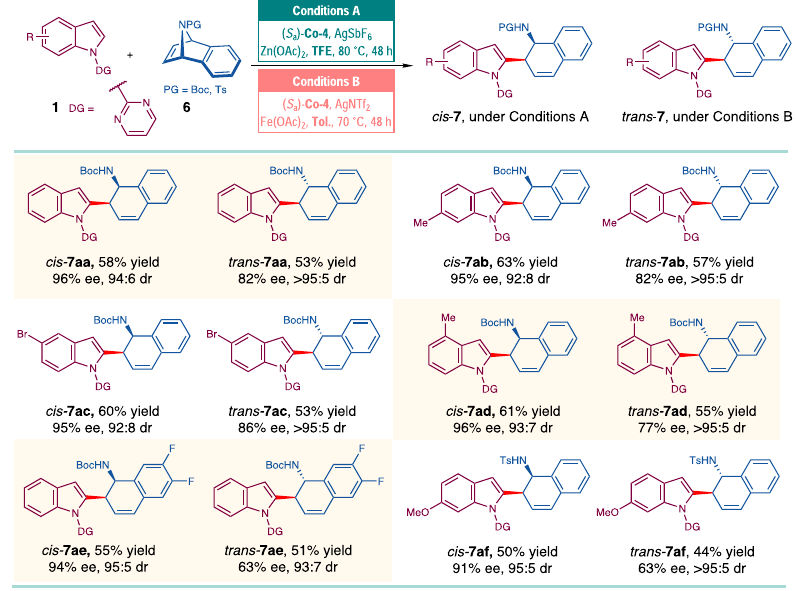
Fig. 6 | ARO reactions of 7-azabenzonorbornadiene. Reaction conditions A: 1 (0.15mmol), 6 (0.10mmol), ( S a )- Co-4 (10mol%), AgSbF 6 (20mol%), Zn(OAc) 2 (50mol%)inTFE(1.0mL)at80°Cfor48h.ReactionconditionsB: 1 (0.15mmol), 6